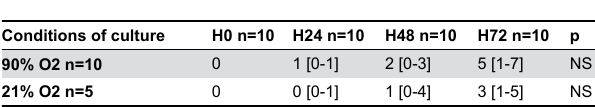
Table 1. Characteristics of the caspase-3 immunochemical staining.